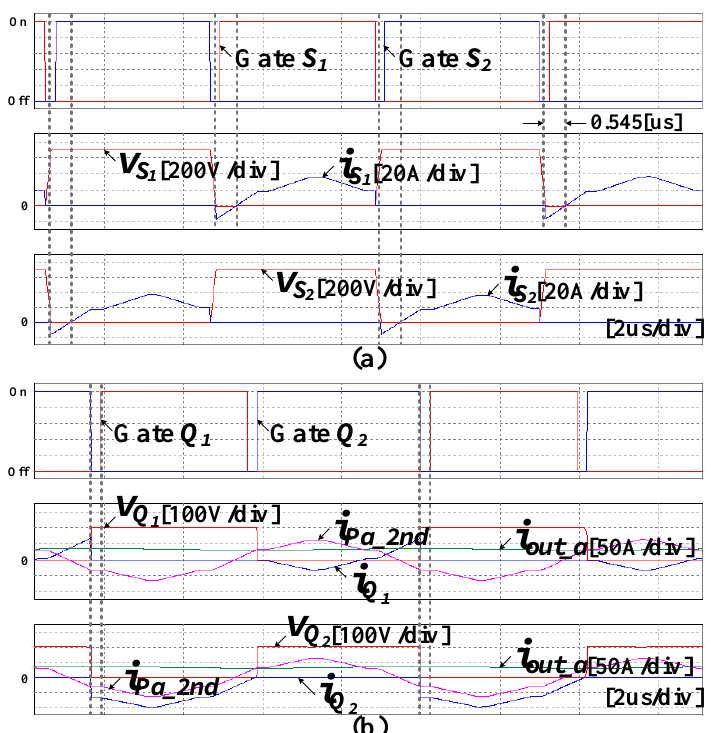
Figure 13. Soft switching simulation results of the 3P-CFDAB converter ( a ) ZVS turn on of primary side switching devices and ( b ) ZVT turn on of secondary side switching devices.